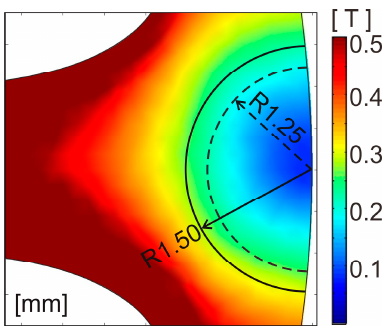
Figure 10. Enlarged view of a region of the back yoke, which is cut out in the Bezier model.